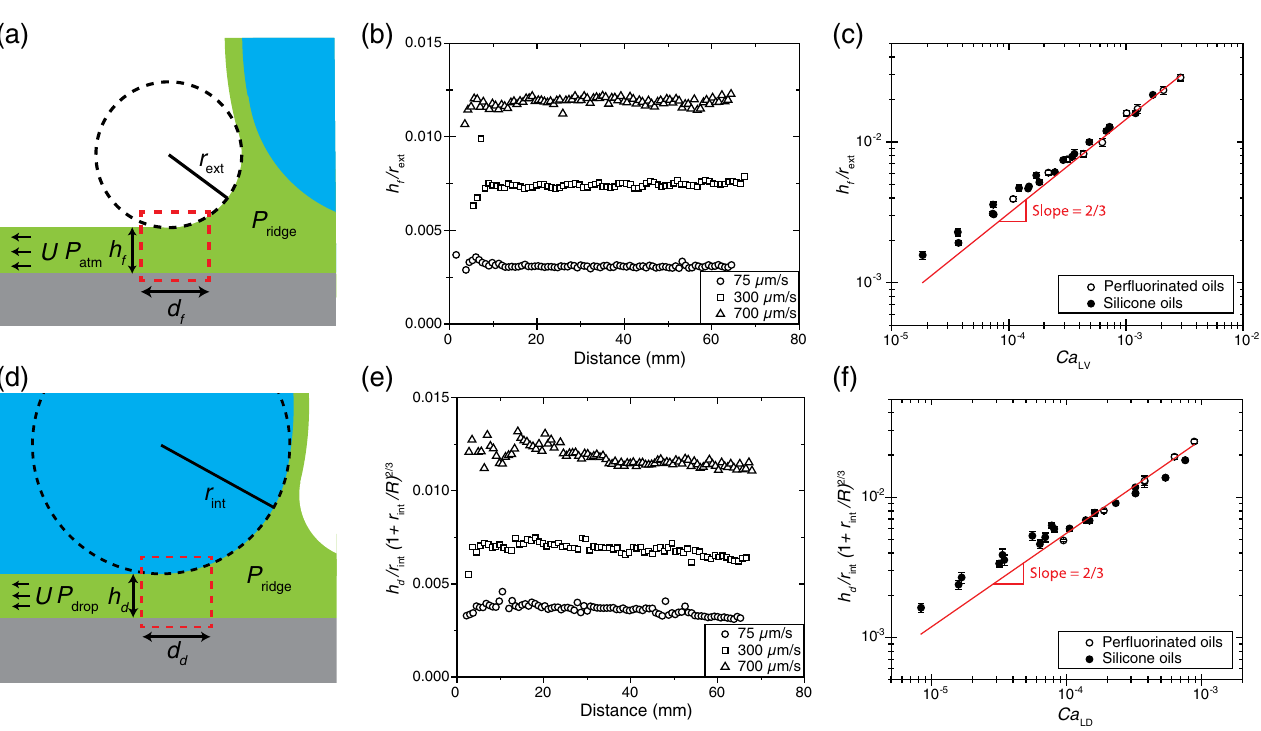
=r at the trail behind the moving droplet. (b) h vs distance for f f ext =r with Ca for f ext LV ð 1 þ r =r =R Þ 2 = 3 vs distance for droplets moving on 20-cP silicone-oil- d int int ð 1 þ r =r =R Þ 2 = 3 with Ca for droplets moving on surfaces d int int LD